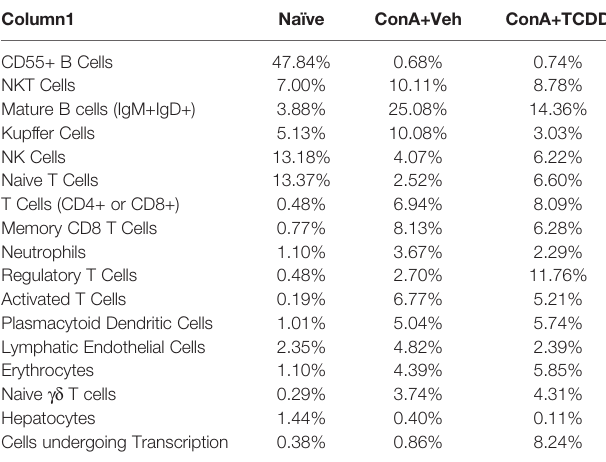
TABLE 2 | Target genes and